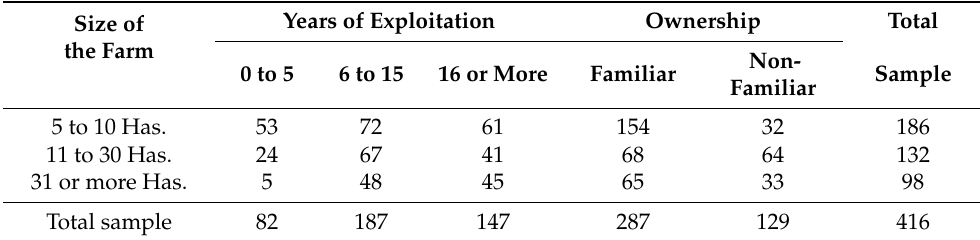
Table 1. Demographical characteristics of the